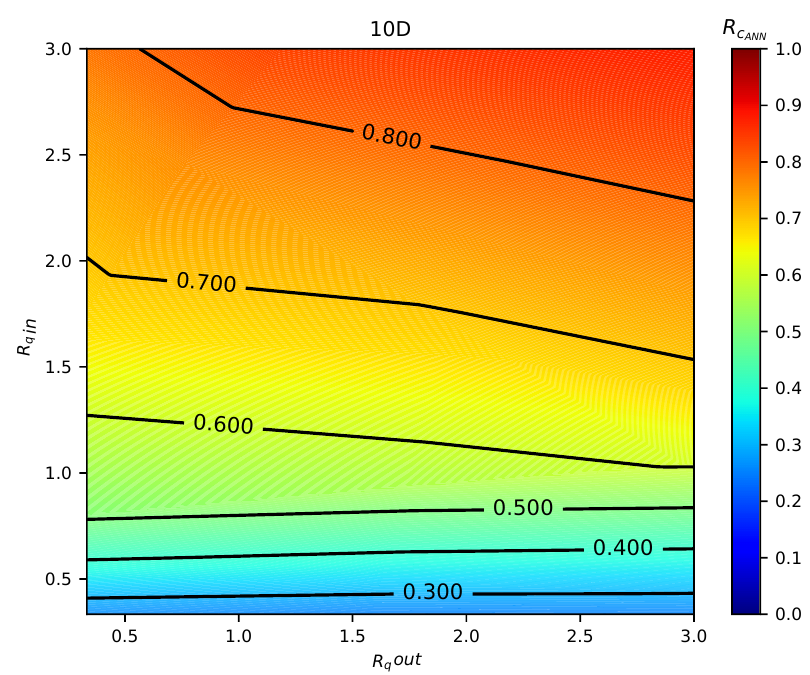
Figure 4. Predicted R c